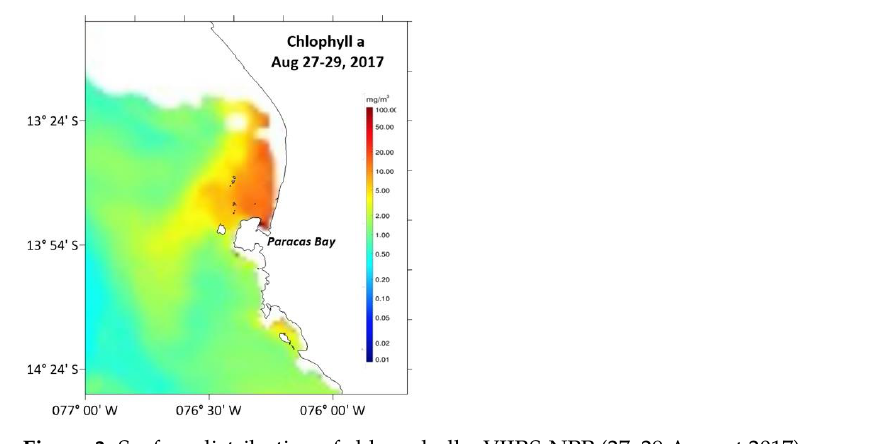
Figure 2. ( a ) Cell density and temperature and ( b ) cell density and dissolved oxygen from Paracas Bay. 3.1.1. Satellite Chlorophyll- a During the P. cordatum bloom, the integrated satellite image of chlorophyll- a from 27 to 29 August 2017 shows high concentrations of this photosynthetic pigment (>10 mg m - 3 ) in Paracas Bay, extending for around 13 km northwards (Figure 3).